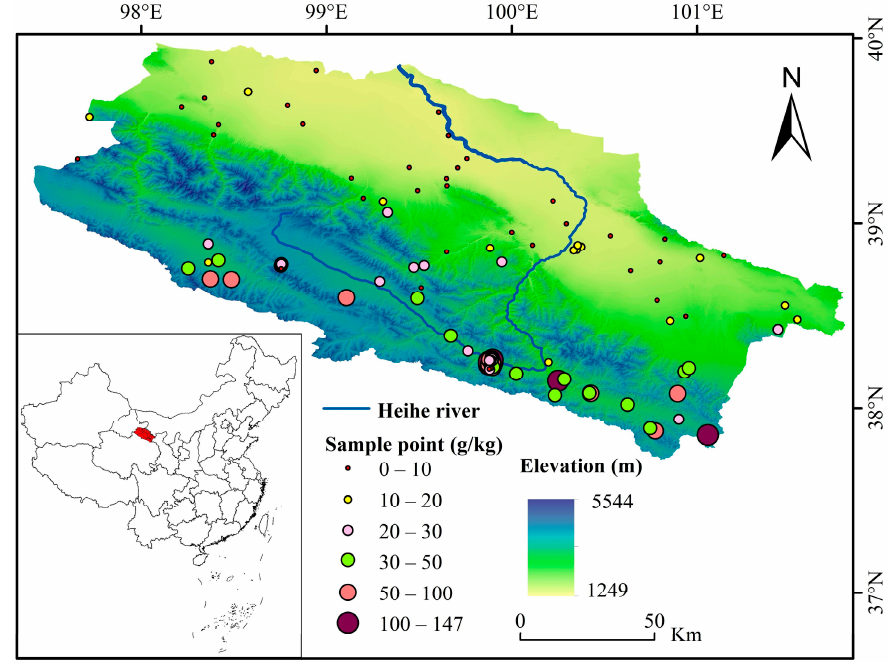
Figure 1. Location of study area and distribution of sample points.